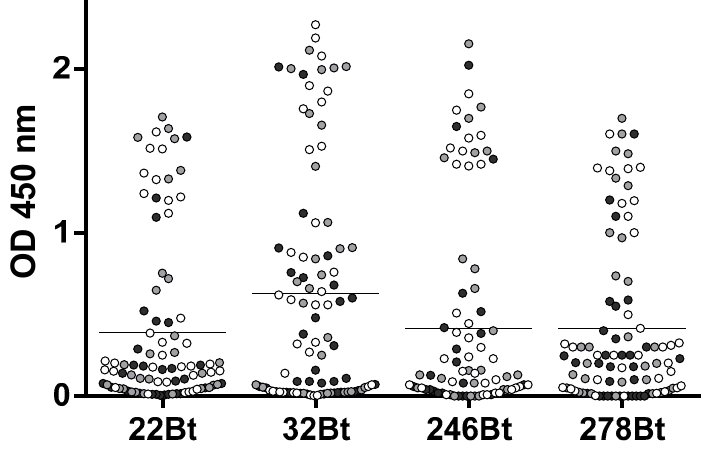
Figure 5. Pairwise screening of detection Nbs. The four capture Nb candidates (BtNB22, BtNb246, BtNb278, and BtNb32) were used to capture ZVNS1 (2 ng/well) and were assayed against the 72 master plate Nb supernatants. Black, gray, and white are used to denote detection Nbs selected with the A, B, and C panning strategies, respectively. The horizontal lines represent the mean OD values.